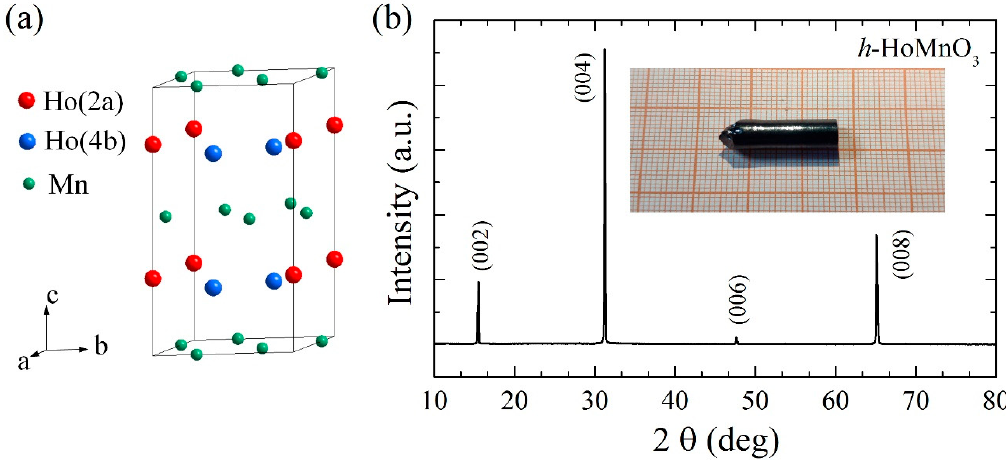
Figure 1. ( a ) Crystallographic geometry of the Mn 3+ and Ho 3+ ions in the h- HoMnO 3 . Two nonequivalent Ho 3+ ions 2 a and 4 b are shown in different colors. ( b ) The orientation of the crystal surface using X-ray scattering analysis for the (002) plane. Inset of Figure 2 shows a picture of the as-grown h- HoMnO 3 single crystal by the optical floating-zone furnace.